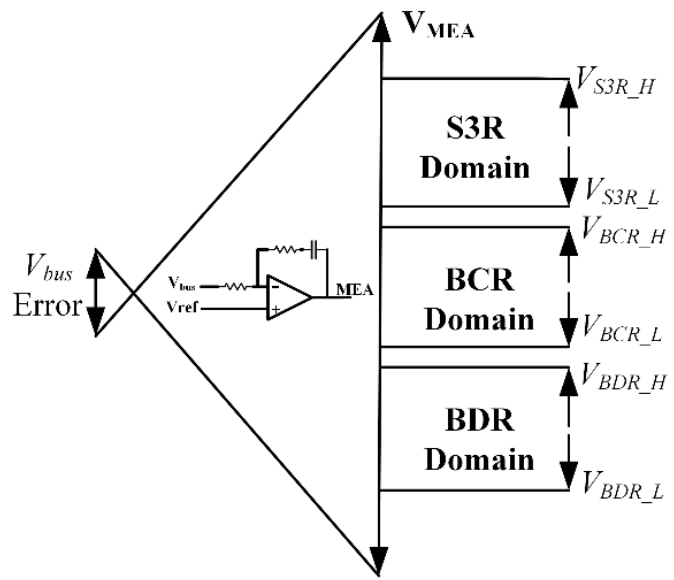
Figure 17. Three ‐ domain control principle of PCU. Figure 17. Three-domain control principle of PCU.